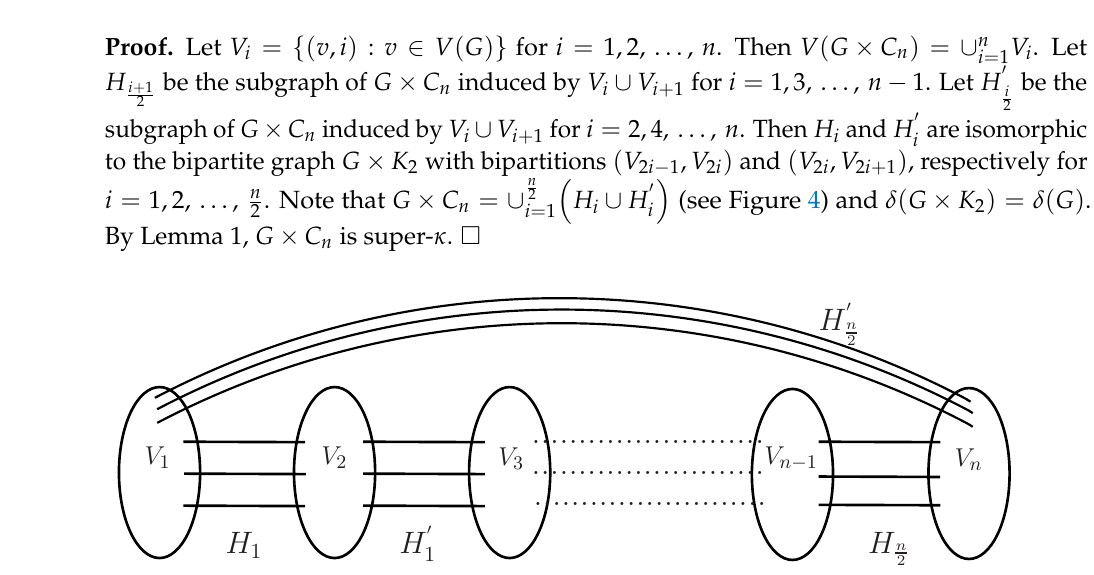
C n when G is non-bipartite and n is an even. Figure 4. The graph G ×